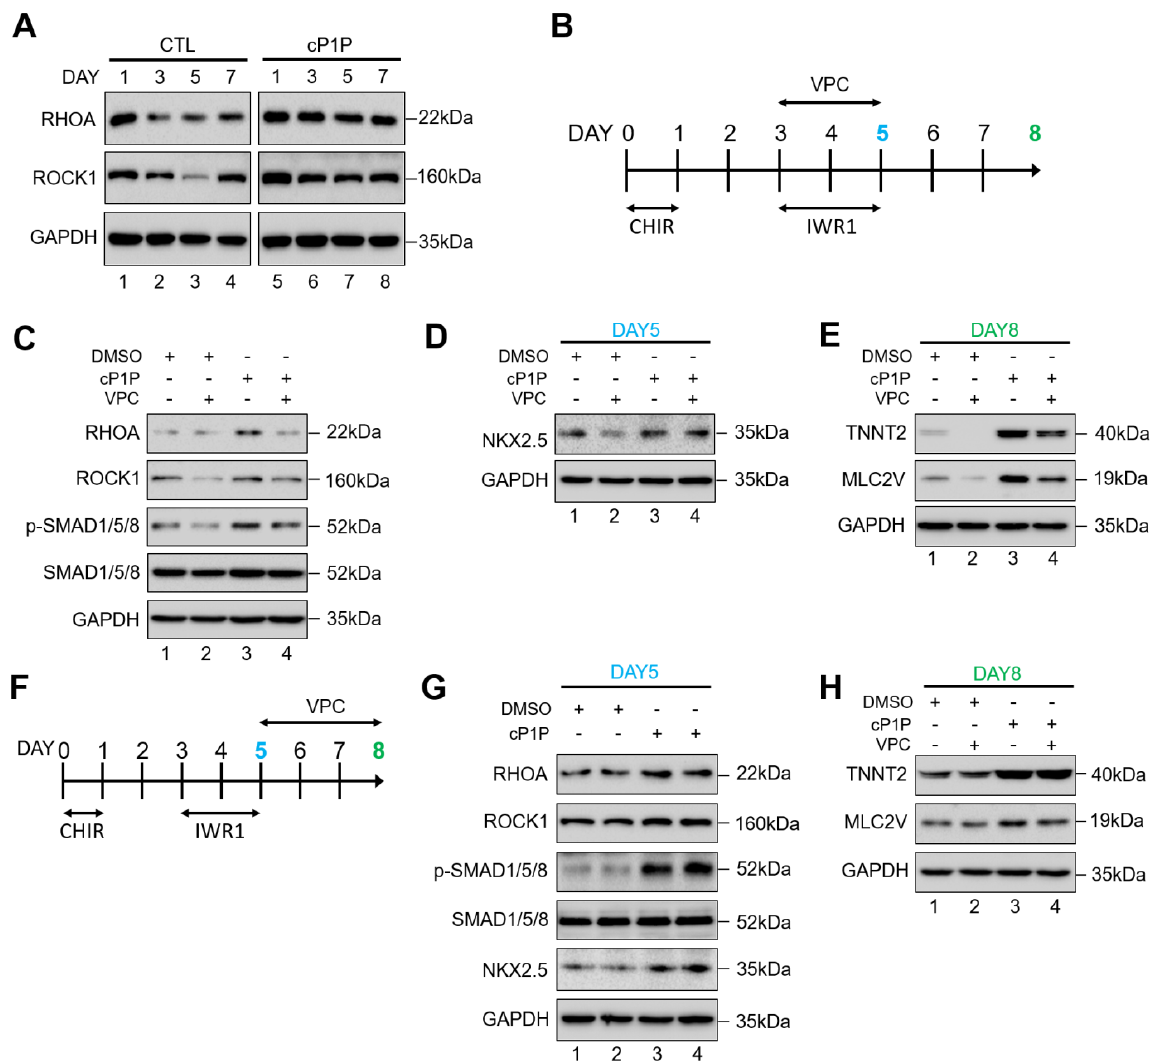
Figure 3. cP1P promotes cardiac differentiation in hESCs by partially regulating S1PR-mediated SMAD1/5/8 signaling. ( A ) The activity of RHOA/ROCK1/SMAD signaling with or without cP1P was tested by evaluating the expression of RHOA and ROCK1 by Western blot at the indicated time points along with GAPDH expression as a reference. ( B ) Schematic representation of the treatment with S1PR inhibitor VPC during days 3 to 5 of CM differentiation coinciding with IWR1 inhibitor treatment. ( C ) The activity of RHOA/ROCK1/SMAD signaling was inhibited by the administration of VPC, as shown by the downregulation of RHOA, ROCK1, and p-SMAD 1/5/8, but cP1P treatment could partly rescue the inhibitory effect of VPC, as shown by the rescue of p-SMAD 1/5/8, demonstrated by Western blot. The effects of S1PR inhibition by VPC on cardiomyocyte differentiation, shown by ( D ) the downregulation of NKX2.5 at day 5. ( E ) Effect of VPC treatment between days 3 to 5 on the expression of TNNT2 and MLC2V at day 8 of CM differentiation showed that cP1P treatment could partially rescue the inhibitory effects of VPC treatment, as demonstrated by Western blot. ( F ) Schematic representation of the treatment with VPC during days 5 to 8 of CM differentiation. ( G ) Immunoblots of RHOA, ROCK1, p-SMAD1/5/8, SMAD1/5/8, and NKX2.5 at day 5 of VPC treatment in DMSO-treated controls and cP1P-treated CMs. ( H ) Immunoblots of TNNT2 and MLC2V at day 8 of VPC treatment in DMSO-treated controls and cP1P-treated